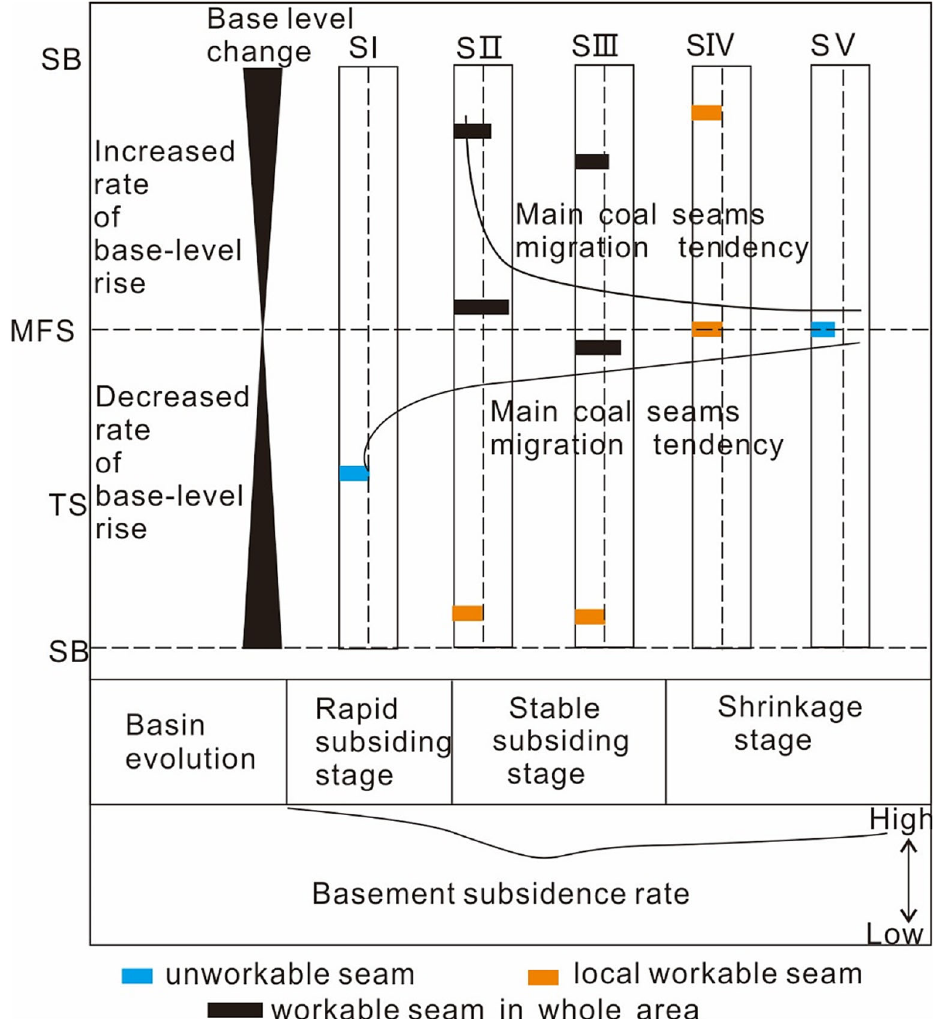
Fig. 4 The distribution of main coal seams in the sequence stratigraphic framework of the study